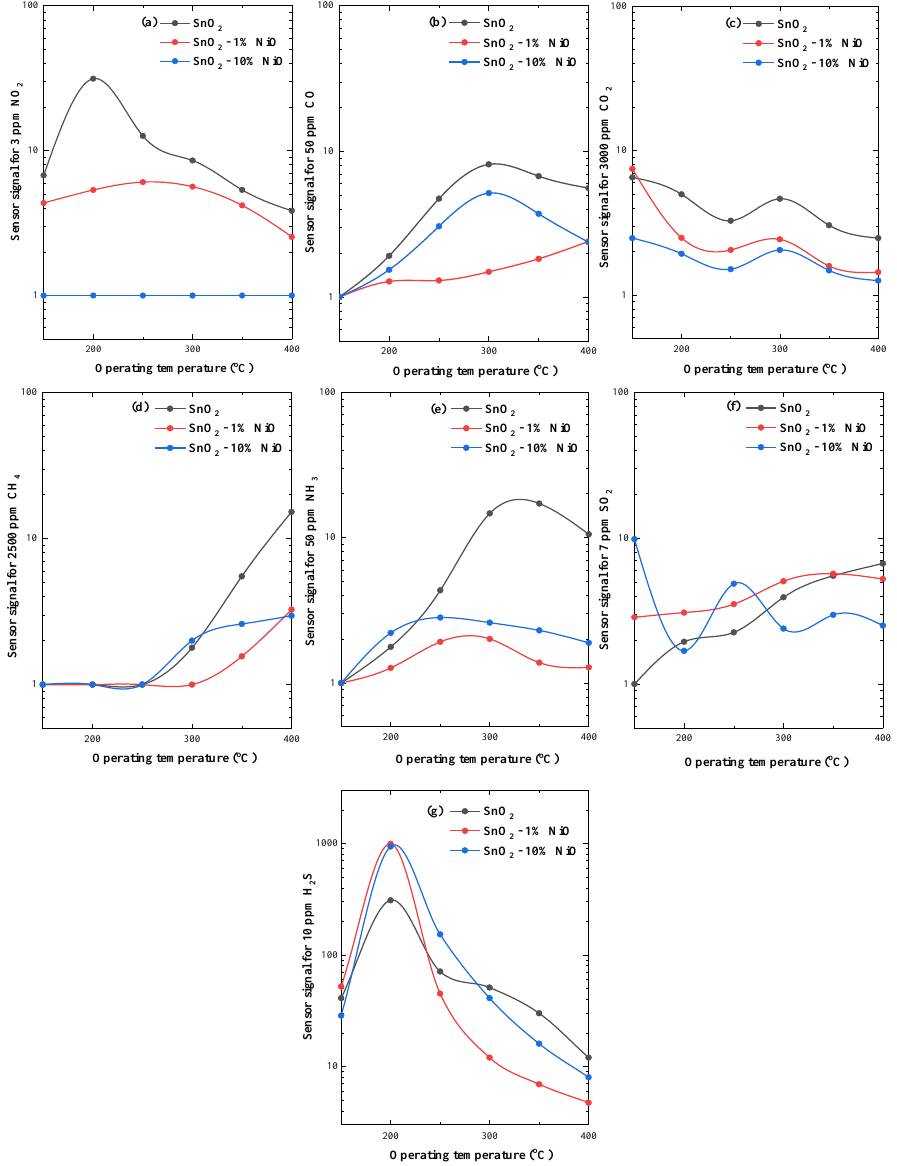
Figure 9. Sensor signal of (1-x) SnO 2 - xNiO (x = 0, 1, 10%) for: 3 ppm NO 2 ( a ); 50 ppm CO ( b ); 3000 ppm CO 2 ( c ); 2500 ppm CH 4 ( d ); 50 ppm NH 3 ( e ); 7 ppm SO 2 ( f ) and 10 ppm H 2 S ( g ), over a wide range of operating temperatures and fixed 50%RH.